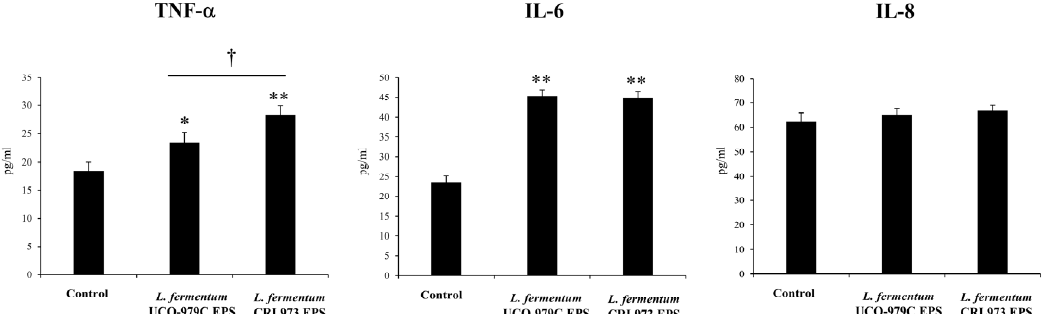
Figure 6. E ff ect of Lactobacillus fermentum UCO-979C or L. fermentum CRL973 EPS on cytokine and chemokine production of human gastric epithelial cells (AGS cells). AGS cells were incubated with 100 µ g / mL of L. fermentum UCO-979C or L. fermentum CRL973 EPS. The levels of TNF- α , IL-6 and IL-8 (pg / mL) in culture supernatants were determined 24 h after stimulation. The results represent data from three independent experiments. Results are expressed as mean ± standard deviation. Significant di ff erences when compared to the control group: * ( p < 0.05), ** ( p < 0.01). Significant di ff erences when compared to the indicated group: † ( p < 0.05).